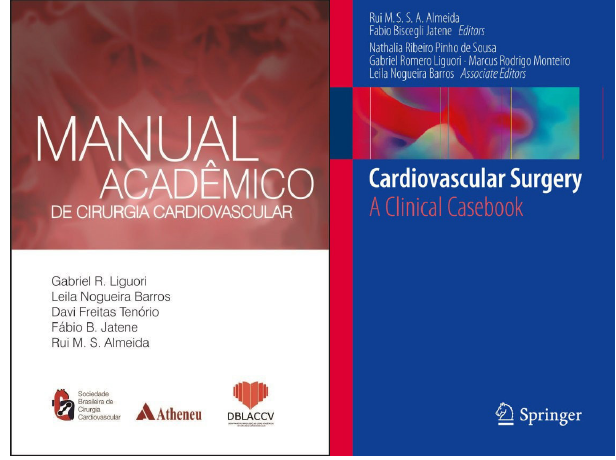
Fig. 2 - Books published by the Brazilian Department of Academic Leagues in Cardiovascular Surgery, in association with the Brazilian Society of Cardiovascular Surgery. The main authors are medical students supervised by graduated surgeons. Image courtesy from